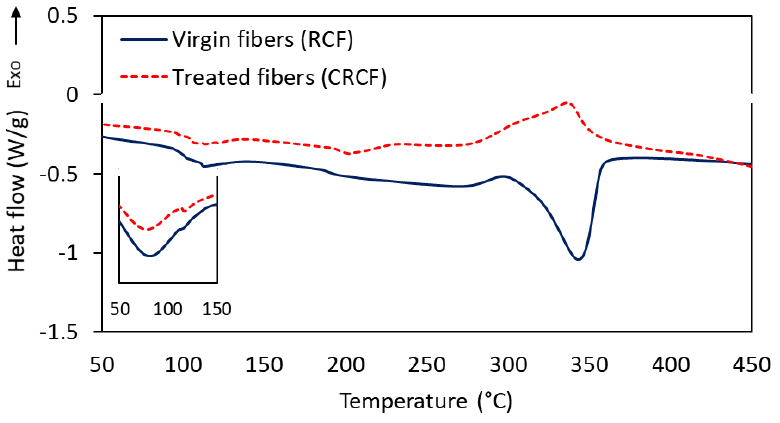
Figure 5. Differential scanning calorimetry (DSC) thermograms of the virgin regenerated cellulose fiber (RCF) (solid line) and electroless copper-plated CRCF (dotted line). The inlet in the figure is for the moisture evaporation peak at the first heating ramp.